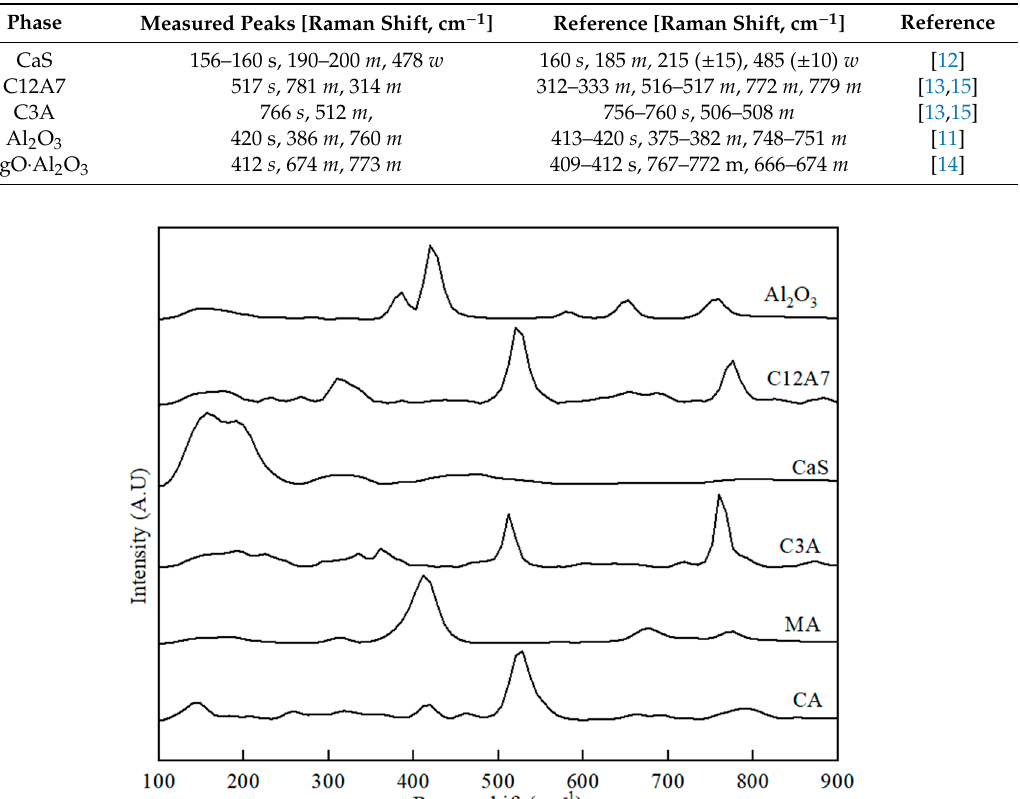
Figure 3. Raman spectra for initial phases of Al 2 O 3 , C12A7, CaS, C3A, MA, and CA used for preparing the binary phase samples.